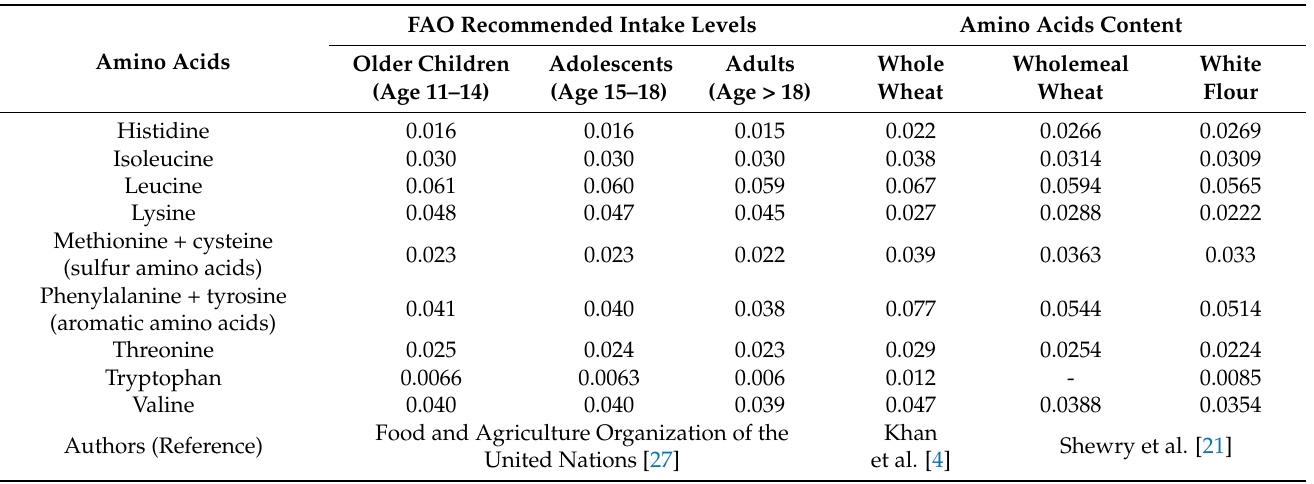
Table 1. Essential amino acid levels recommended for older children, adolescents, and adults compared with those in whole wheat, wholemeal wheat, and white flour (expressed as g/g protein).